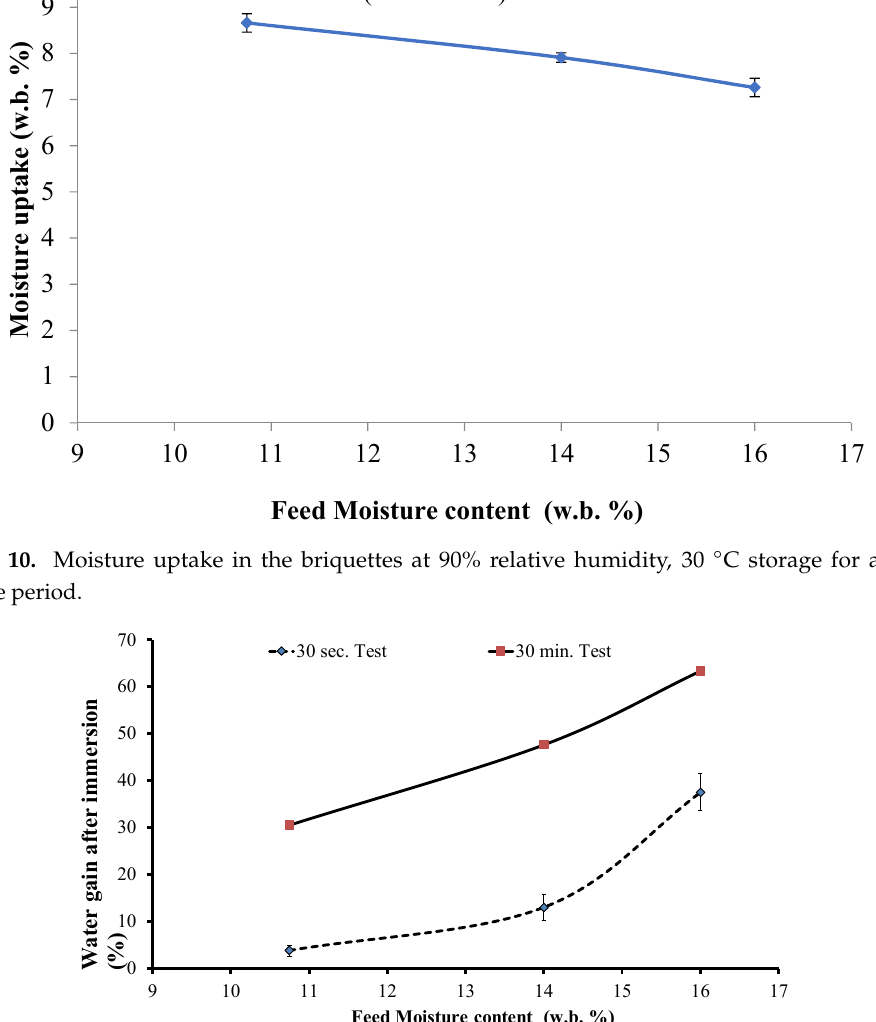
Figure 11. Water gain after immersion vs. feed moisture content for two test periods.